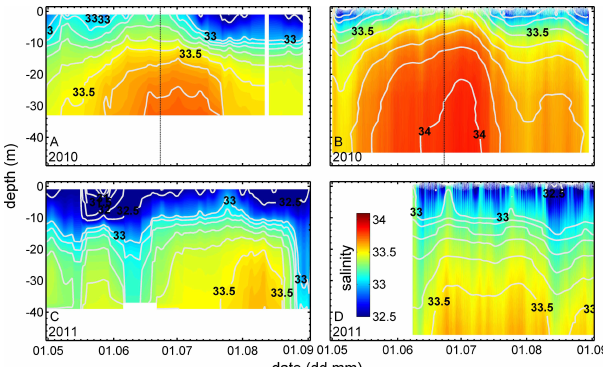
Fig. 10. Weekly time series of salinity profiles at Lynn of Lorne in Ardmucknish Bay (56 ◦ 28.91 0 N, 5 ◦ 30.10 0 W) from CTD casts (left-hand panel) and calculated with the FVCOM model (right- hand panel) for the summers of 2010 ( a, b ) and 2011 ( c, d ). The onsets of the overturning events in the deep basin of Loch Etive are indicated by dashed vertical lines. The presence of a pool of high- density (high-salinity) water at the entrance to Loch Etive in 2010 and its absence in 2011 is reproduced well by the